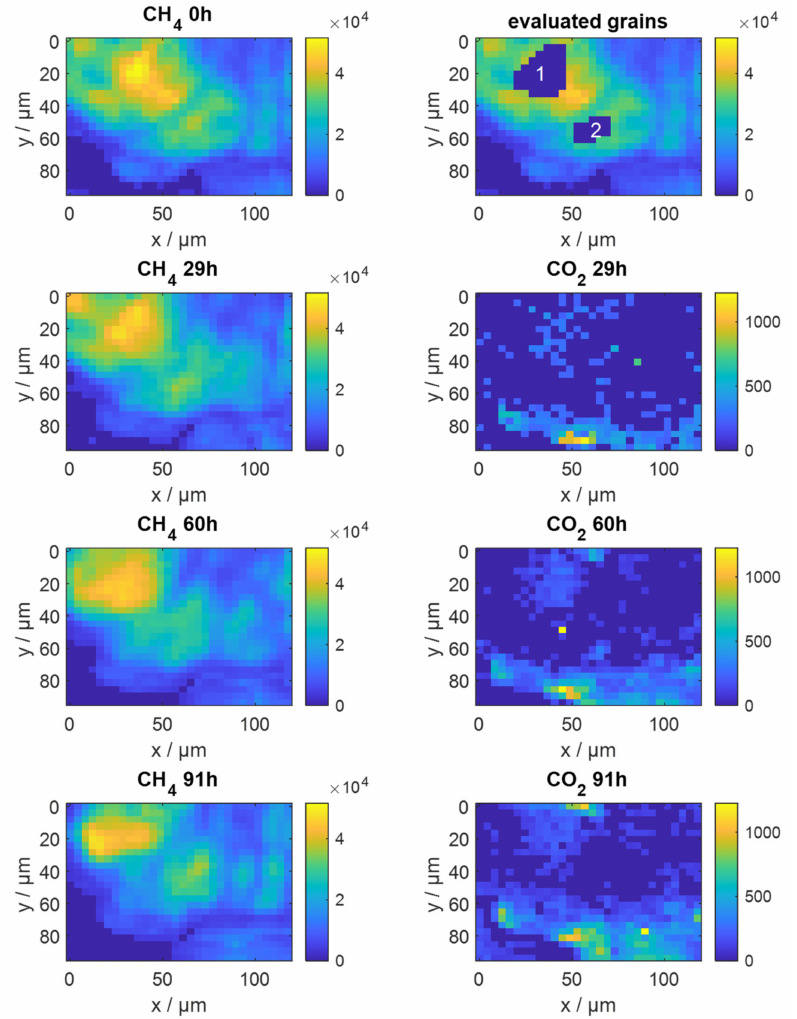
Figure 3. CH 4 and CO 2 hydrate maps of experiment NoFlow at times 0 h (only CH 4 hydrate), 29 h, 60 h, and 91 h. Signal intensities are shown in arbitrary units. The location of the two selected gas-hydrate grain areas for gas-exchange evaluation are marked as blue areas in the upper-right